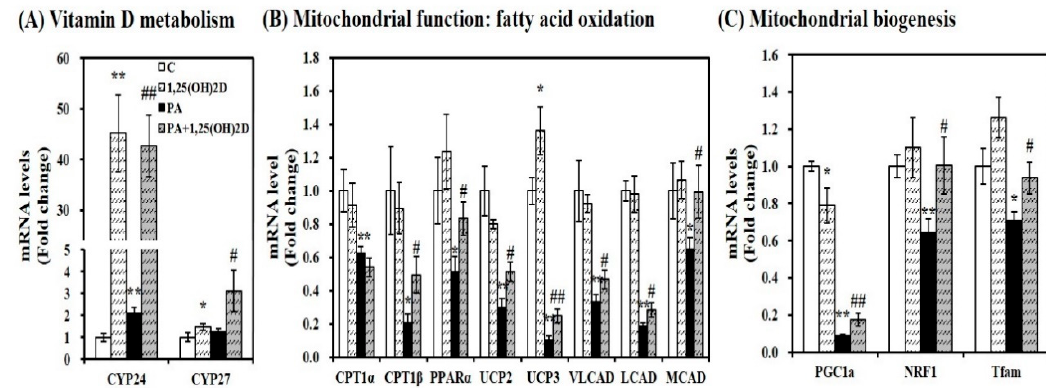
Figure 8. Influence of 1,25-dihydroxyvitamin D (1,25(OH)2D) on mRNA expression involved in vitamin D metabolism and mitochondrial biogenesis and function in C2C12 muscle cells. Gene expression was determined by RT-PCR and normalized for all samples to β -actin. ( A ) vitamin D responsive genes; ( B ) mitochondrial function; ( C ) mitochondrial biogenesis. Results represent mean ± SEM from two experiments ( n = 6 per group). * p < 0.05; ** p < 0.01 compared to vehicle control. # p < 0.05; ## p < 0.01 compared to PA control. C, vehicle treated C2C12 muscle cells; PA, 0.5 mM palmitic acid-treated myotubes; PA + 1,25(OH)2D, pretreatment with 0.5 mM PA following 1,25(OH)2D incubation (100 nM, 24 h).